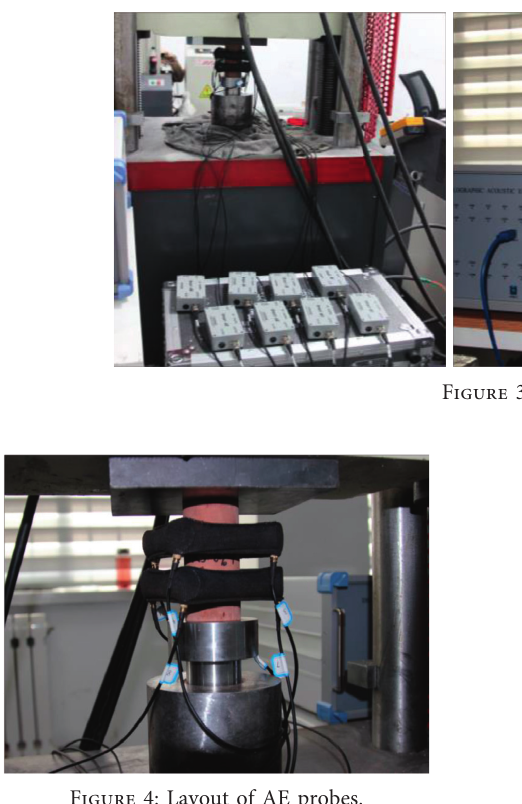
Figure 4: Layout of AE probes.